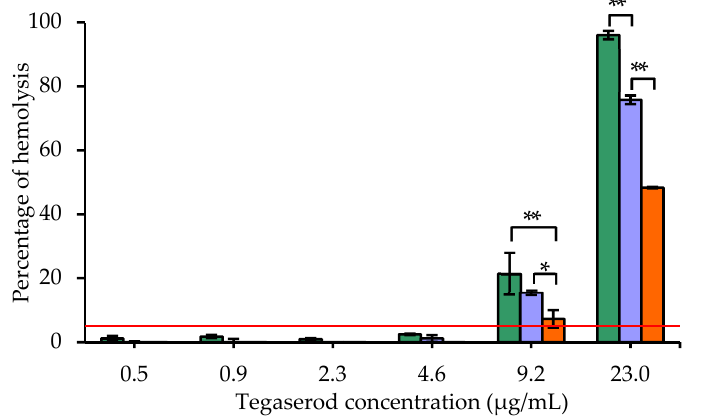
Figure 7. Results of the hemolysis test for the suspension of tegaserod (in green), Tg-NEs (in blue) and P22-Tg-NEs (in orange). The red line represents the threshold value of 5%. Note: Data are shown as mean ± standard deviation ( n = 3). * p < 0.05; ** p < 0.0001.